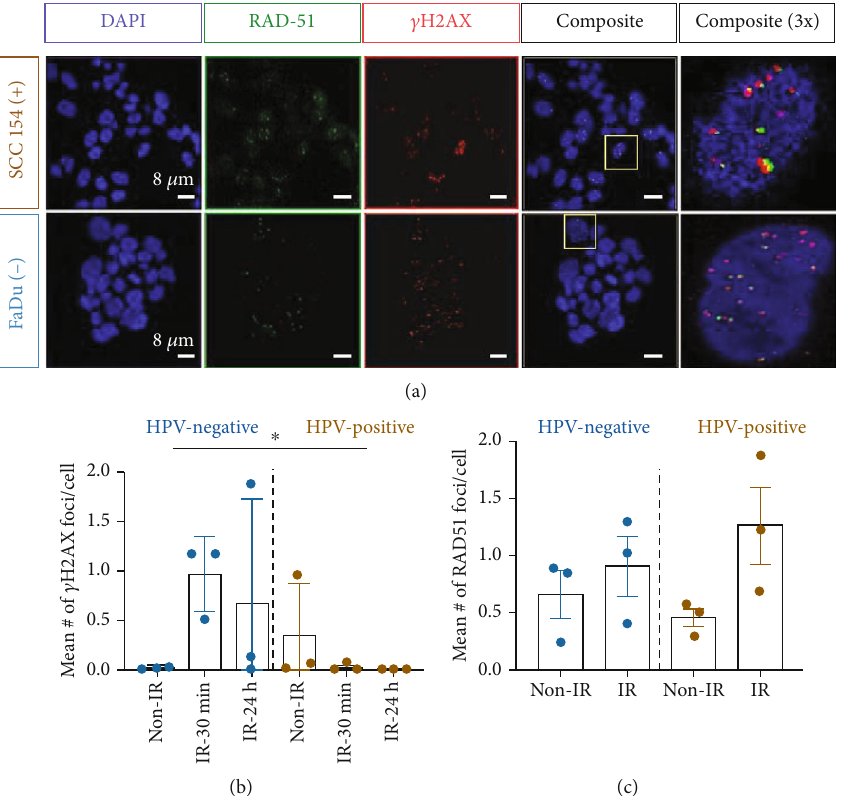
Figure 2: E ff ect of radiation on HPV-negative and HPV-positive cells. (a) Immuno fl uorescence staining using ɣ H2AX and RAD51 antibodies performed on three HPV-negative (FaDu, Cal 27, and SCC 15) and three HPV-positive (SCC 090, SCC 154, and SCC 152), irradiated (2 Gy) and nonirradiated (0 Gy), cell lines. Representative images showing DAPI (blue), RAD51 (green), and ɣ H2AX (red), 24 h postirradiation. IgG control in Supplementary Fig. S3. (b, c) Quanti fi cation of the mean number of ɣ H2AX and RAD51 foci calculated per cell for di ff erent conditions ( ∗ P < 0 : 05 , Student t